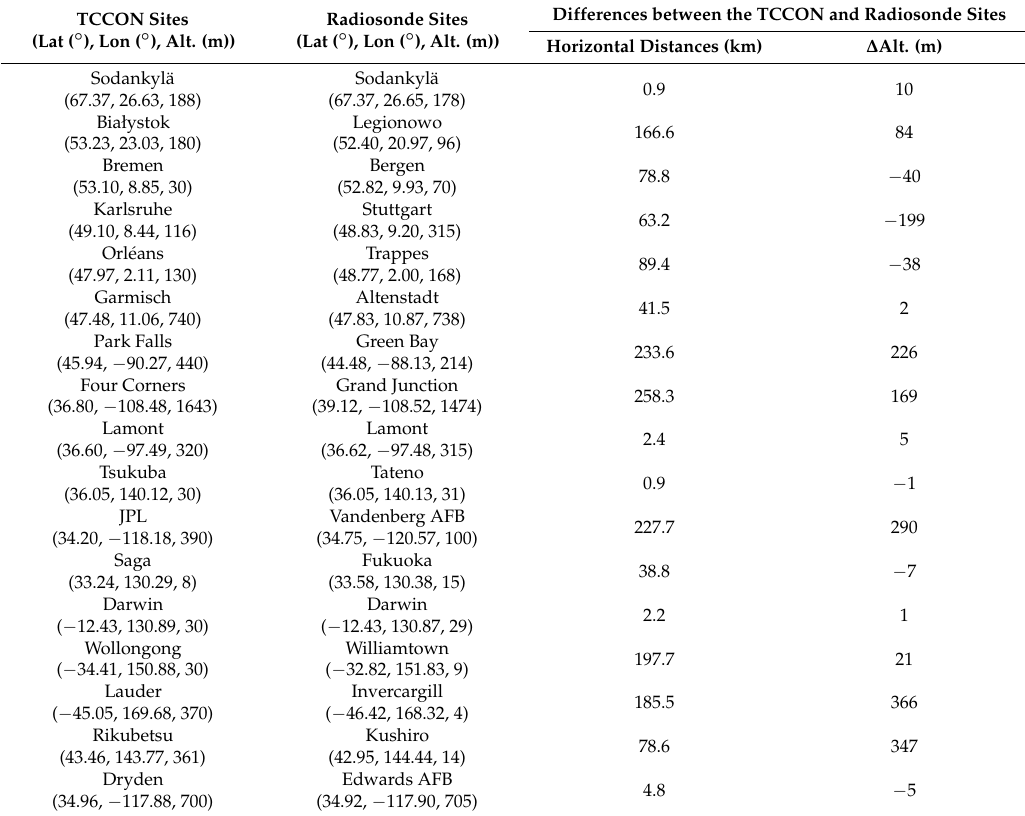
Table A1. Coordinates of TCCON sites and nearby radiosonde launch sites.